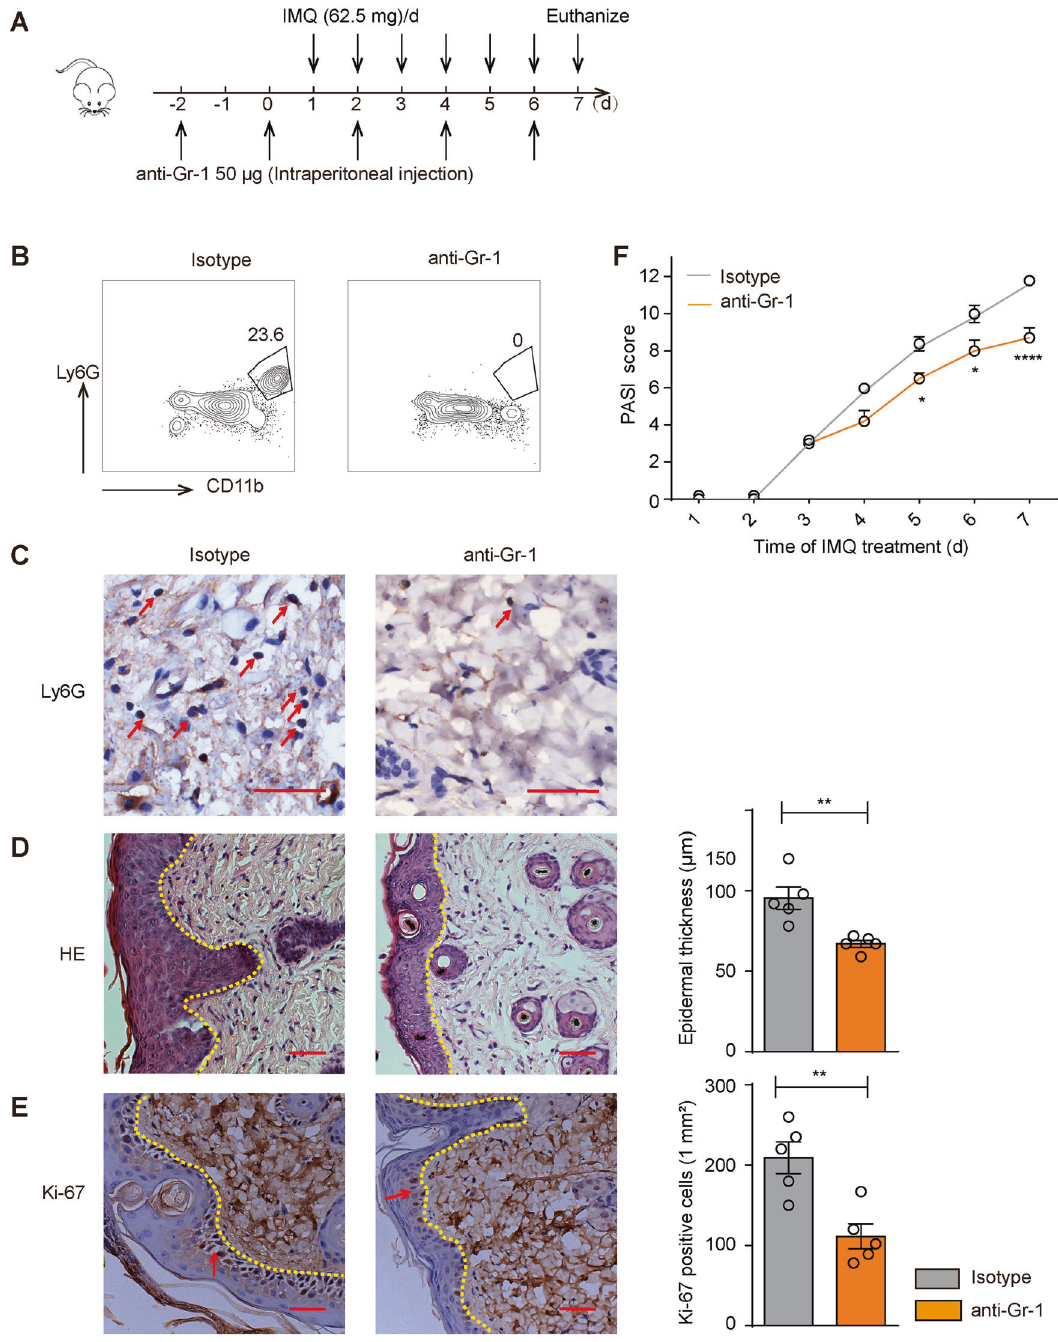
Fig. 3 Neutrophil depletion attenuated psoriatic in fl ammation. The psoriatic mice were randomly assigned into two groups. They were either injected with 50 µg anti-mouse Gr-1 or isotype control antibody ( n = 5 mice for each group). The anti-mouse Gr-1 was injected intraperitoneally every other day from days − 2 to 7. Skin samples on day 7 were for H&E staining and fl ow cytometry. A The experimental scheme. B Flow cytometry analysis of neutrophils in the indicated groups. C The Ly6G immunostaining of the skin; enumeration of Ly6G positive cells. D H&E staining of the skin in the indicated groups; measurement of epidermal thickness. E The Ki-67 immunostaining of the skin in both groups; enumeration of Ki-67 positive cells. F The PASI scores were monitored daily in the indicated groups during the entire experiment. Data were shown as means ± SEM. Scale bars: 50 µm. * p < 0.05, ** p < 0.01, **** p <